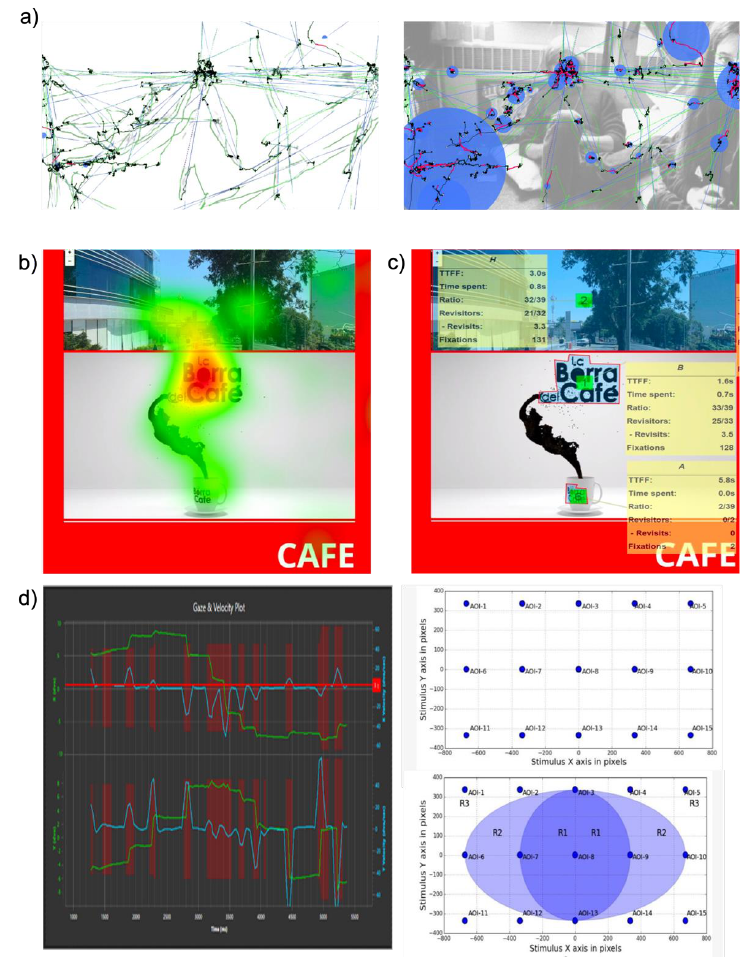
Figure 13. Eye tracking algorithms: ( a ) graphical overview of gaze tracking and mapping, overlap- ping data on user’s eye view (Reproduced under terms of the CC -BY license [167]. Copyright 2020, the Authors. Published by DOAJ). ( b ) Heatmap and dwell time analysis (Reprinted under terms of the CC-BY license [157]. Copyright 2022, the Authors. Published by MDPI). ( c ) Analyzed AOI from